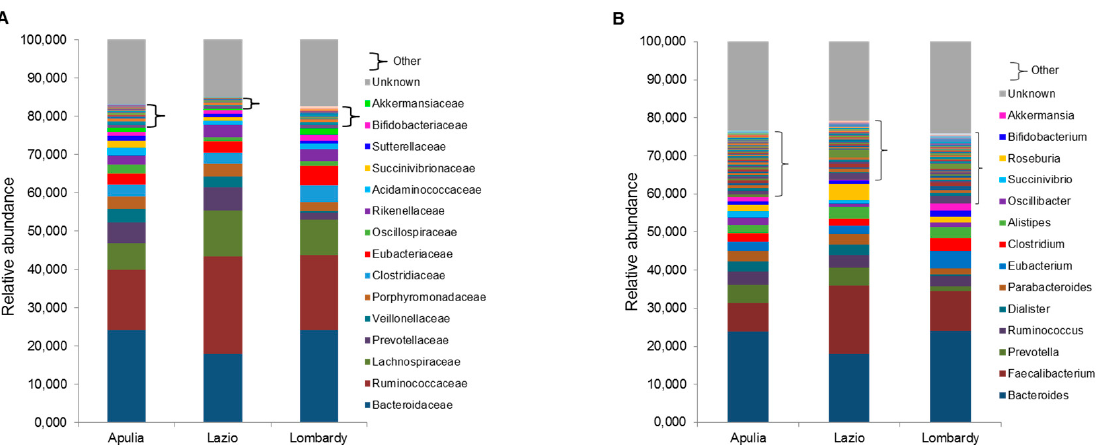
Figure 2. Microbiota composition of Italian healthy subjects grouped by regions, at the family ( A ) and genus ( B ) levels. The mean value of all the detected taxa at each level is represented.